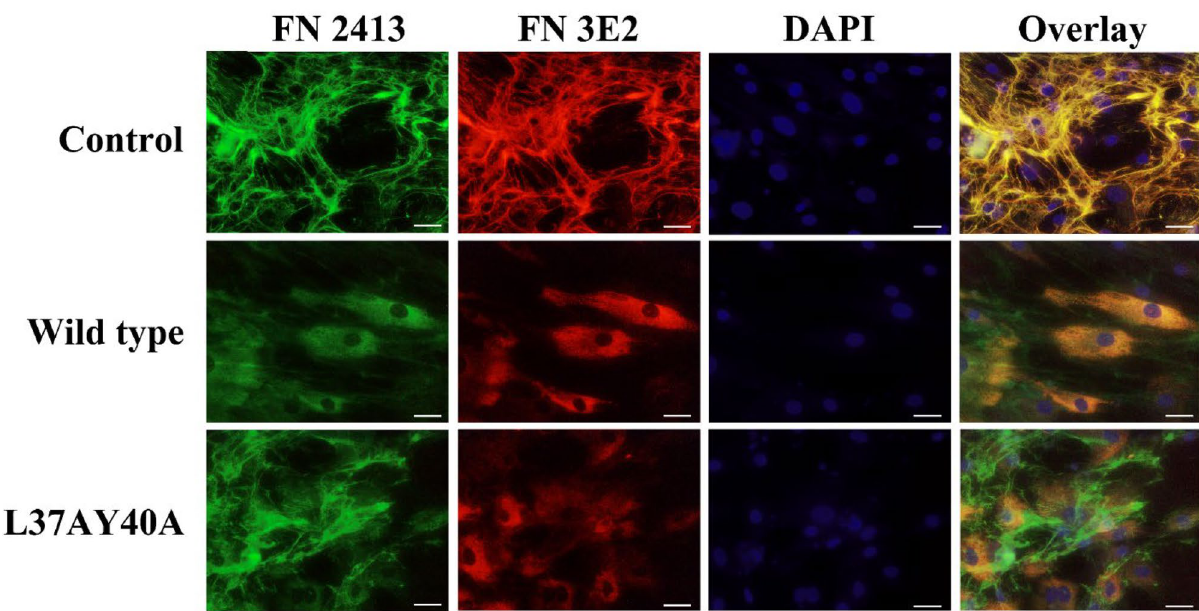
Figure 1. AN influences FN structure in ECM from cells cultured in growth media. Primary HCASMC at an initial density of 2.25 × 10 4 cells per well in 8-well chamber slides were cultured overnight in growth media and then incubated in growth media containing 30 μM AN (wt or L37AY40A) for 48 h. The cells were then fixed and permeabilized followed by incubation with primary antibodies at 4 °C overnight. Total FN was visualized by an anti-FN pAb (2413, 1:500, green channel) and a mAb against the EDA module of cell-derived FN (3E2, 1:500, red channel). Nuclei were counterstained using DAPI (blue channel). Overlays of the three channels are shown on the right. Scale bars: 20 μm. Pixel intensity plots from three independent experiments are displayed in Supplementary Fig.